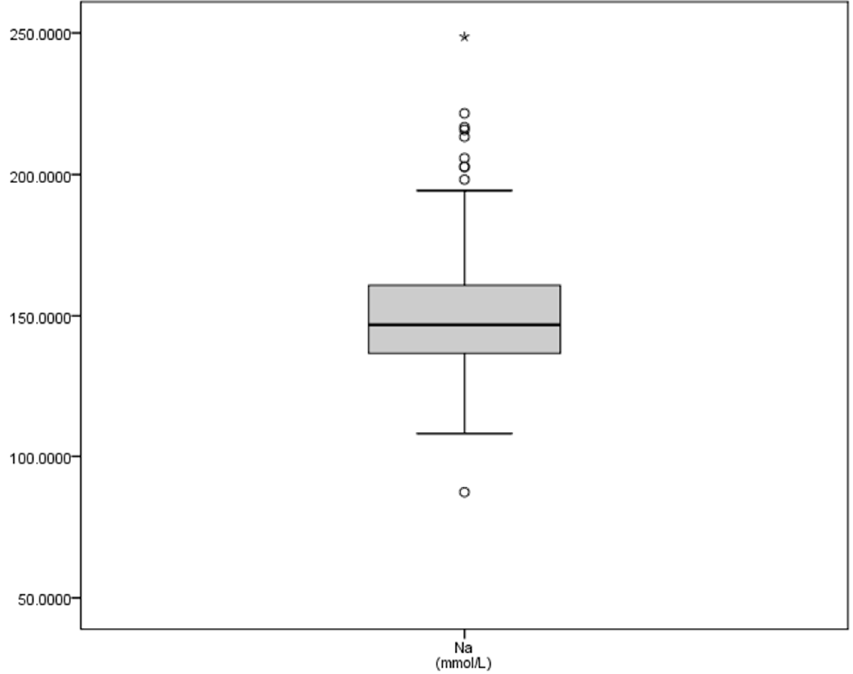
Figure 2. Graphic representation of the natremia of bulls after physical exercise. Footnotes: Na: sodium, in mmol/L.